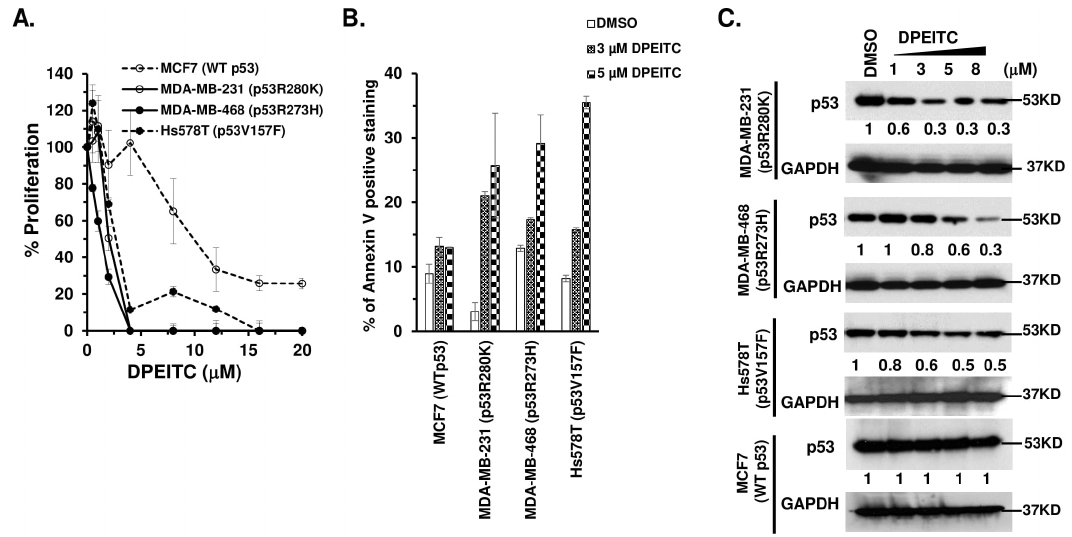
Figure 1. DPEITC inhibits cell proliferation, induces apoptosis, and affects mutant p53 expression levels in TNBC cell lines with mutated p53. MCF7 (WT p53), MDA-MB-231 (p53 R280K ),